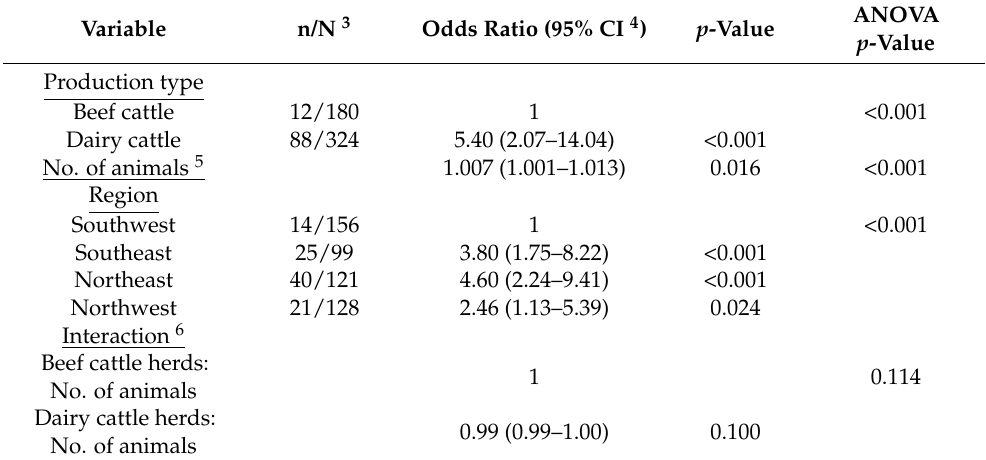
Table 2. Binomial logistic regression analyses of risk factors associated with Coxiella burnetii - seropositive cattle herds sampled for national surveillance programs in Estonia during